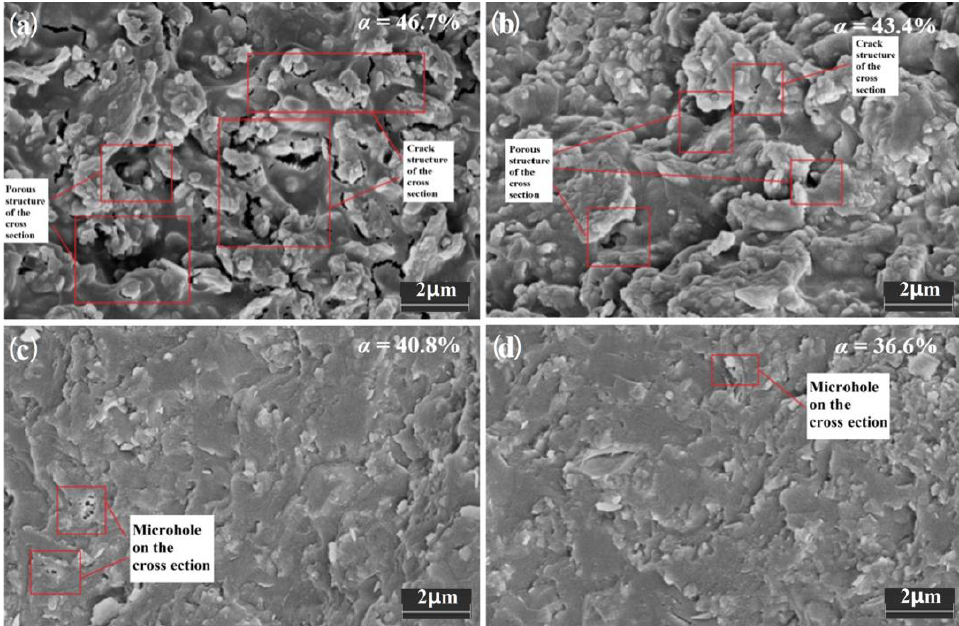
Figure 3. Microstructure of sintered samples with different α values.